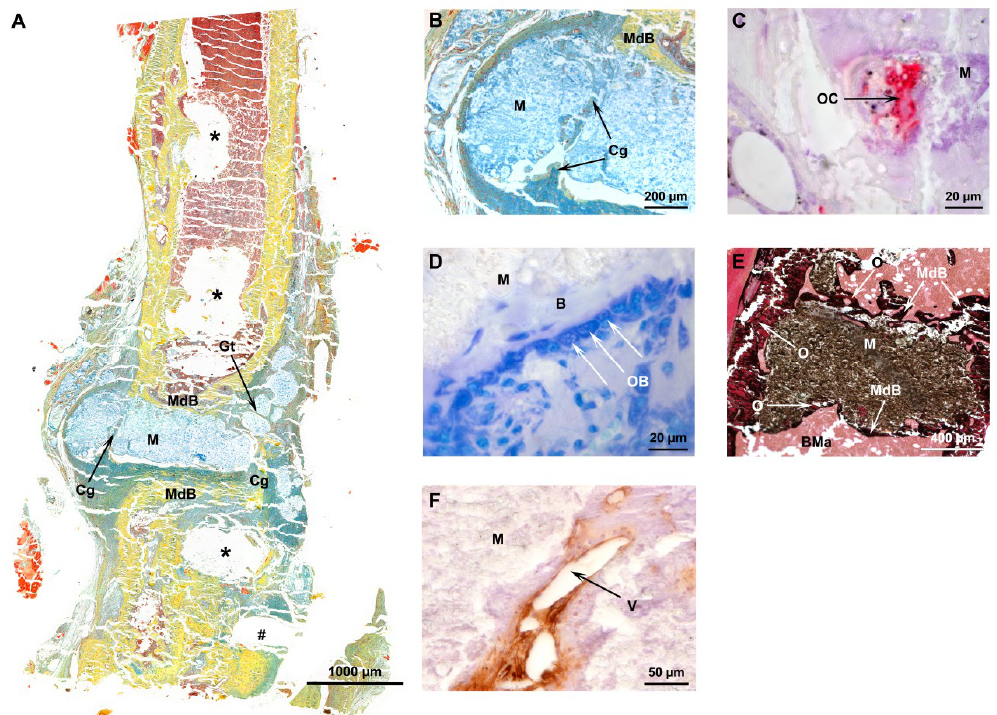
Figure 3. Histology: ( A ) Movat pentachrome staining of a femur section, ( B ) close-up of the same section showing the cement/MBG composite (M), granulation tissue (Gt) in green, cartilage (Cg) in greenish blue and mineralized bone (MdB) in yellow, * point out positions of screws and the # depicts the location of the locking pin, ( C ) osteoclast (OC) visualized by TRAP in red, ( D ) osteoblasts (OB) visualized by toluidine blue, B indicates bone tissue ( E ) mineralization visualized by von Kossa/van Gieson in black, ( F ) ASMA detection of a blood vessel (V); O = osteoid, BMa = bone marrow.